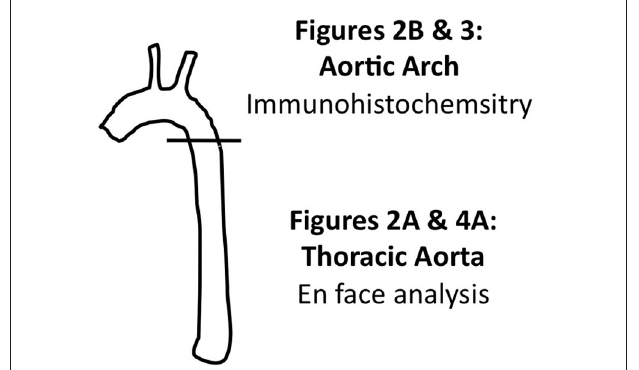
FIGURE 1 | Schematic of artery preparations. Mouse aortic tissues were handled identically for both genome-wide and bone marrow transplant atherosclerosis studies. Aortic arches were fixed and sectioned for immunohistochemical analysis. Descending thoracic aortas were fixed, cleaned and stained with Sudan IV for en face